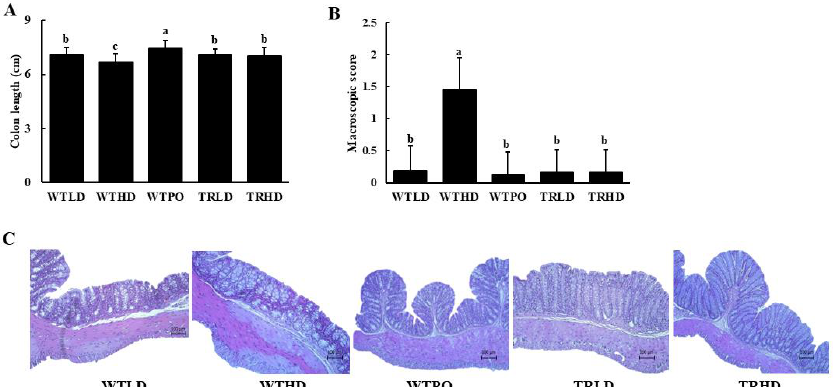
Figure 2. ( A ) Colon length, ( B ) macroscopic score, and ( C ) histological changes. Mice were divided into five groups ( n = 8); WTLD and TRLD fed a low-fat diet (LD, 10% kcal from fat); WTHD and TRHD fed a high-fat diet (HD, 60% kcal from fat); WTPO fed an HD + PO diet (60% kcal from fat diet, supplemented with 8% perilla oil in the diet). Values are expressed as mean ± SD, and those with different superscript (a, b, c) letters indicate significance between groups by ANOVA with Duncan’s test at p < 0.05.